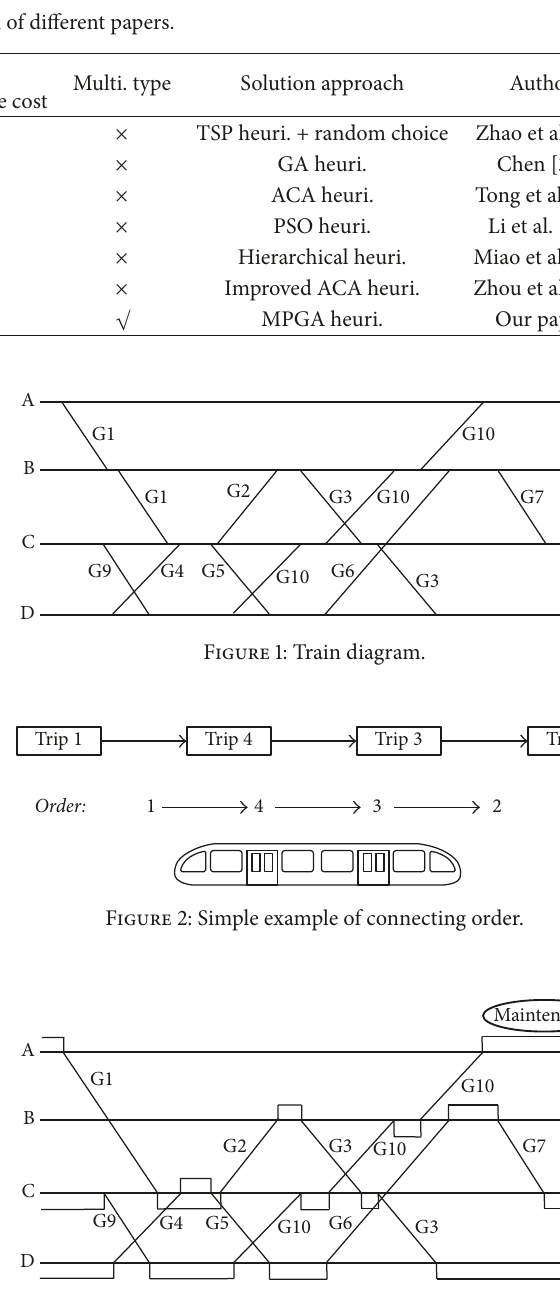
different TCPs based on the same TD. The goal of the TCPP is to find a better solution that needs fewer train-sets and reduces maintenance